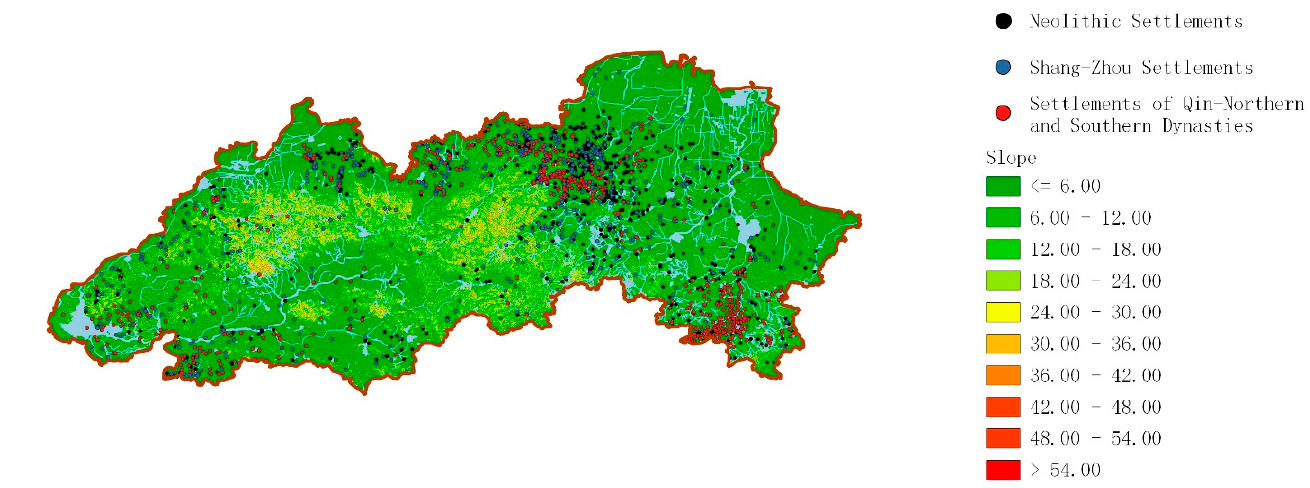
Figure 6. Slope distribution of settlements in different periods.